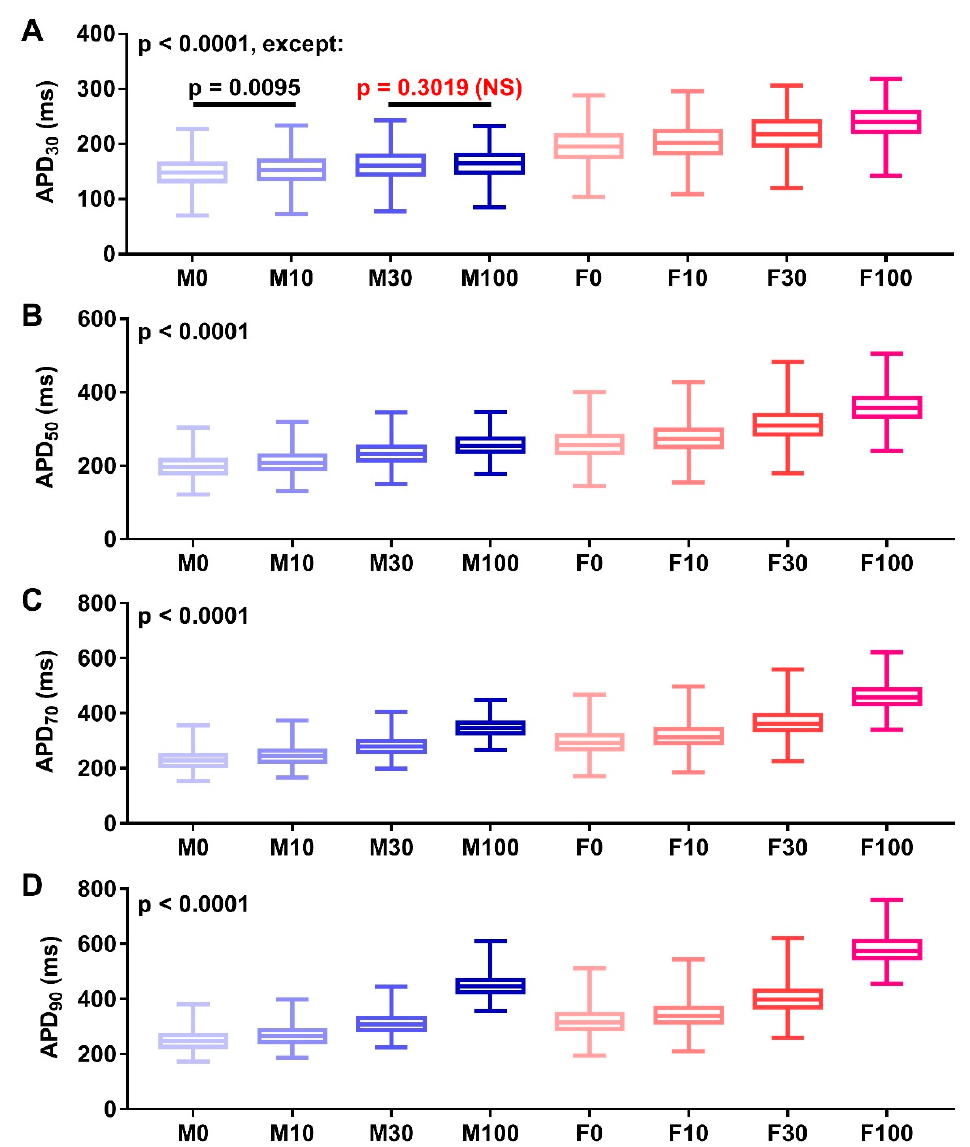
Figure 5. The comparison of action potential durations (APDs; APD 30 ( A ), APD 50 ( B ), APD 70 ( C ) and APD 90 ( D )) for various concentrations of naringenin. The data were extracted from the population of models consisting 1000 model variations shown in Figure 4. Statistical analyses were performed using one-way analysis of variance (ANOVA) with Tukey’s multiple comparison test between concentrations in males and females, and in the same concentrations across sex (i.e., M0 vs. M10, M0 vs. M30, M0 vs. M100, M10 vs. M30, M10 vs. M100, M30 vs. M100, F0 vs. F10, F0 vs. F30, F0 vs. F100, F10 vs. F30, F10 vs. F100, F30 vs. F100, M0 vs. F0, M10 vs. F10, M30 vs. F30, and M100 vs. F100). Statistical significance is reached if p < 0.05.